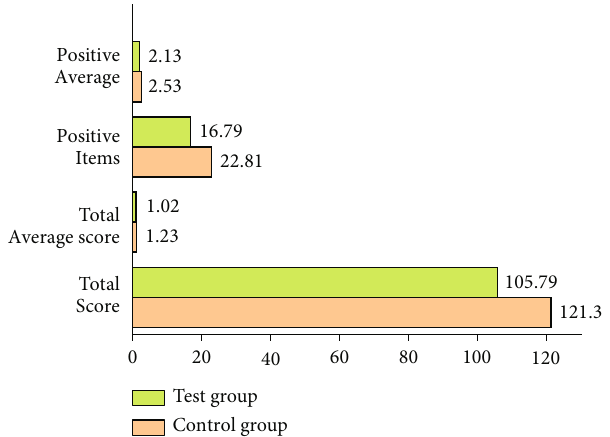
Figure 8: Comparison of the total score and mean score after mental health